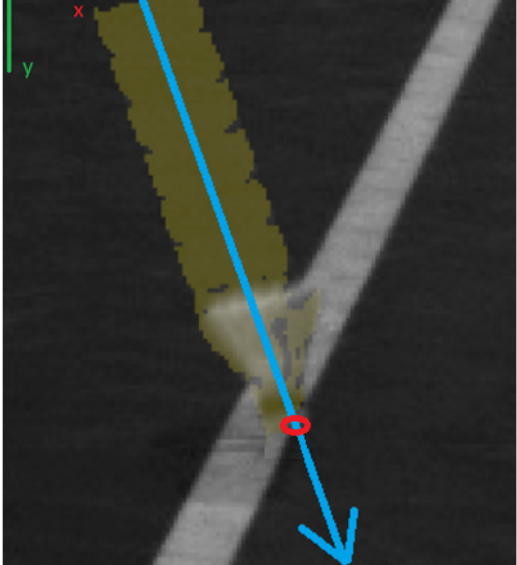
Figure 12. Accumulated diff (yellow) together with an original image. Red circle = ground touch point. Blue arrow = movement direction.